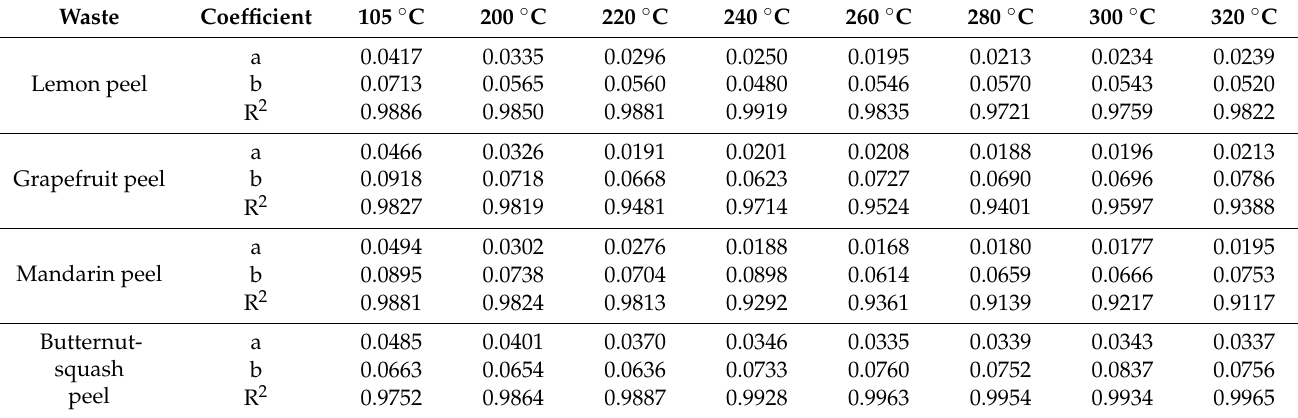
Table 7. Determined parameters a and b and the coefficient of determination (R 2 ) for logarithmic trend lines. Waste